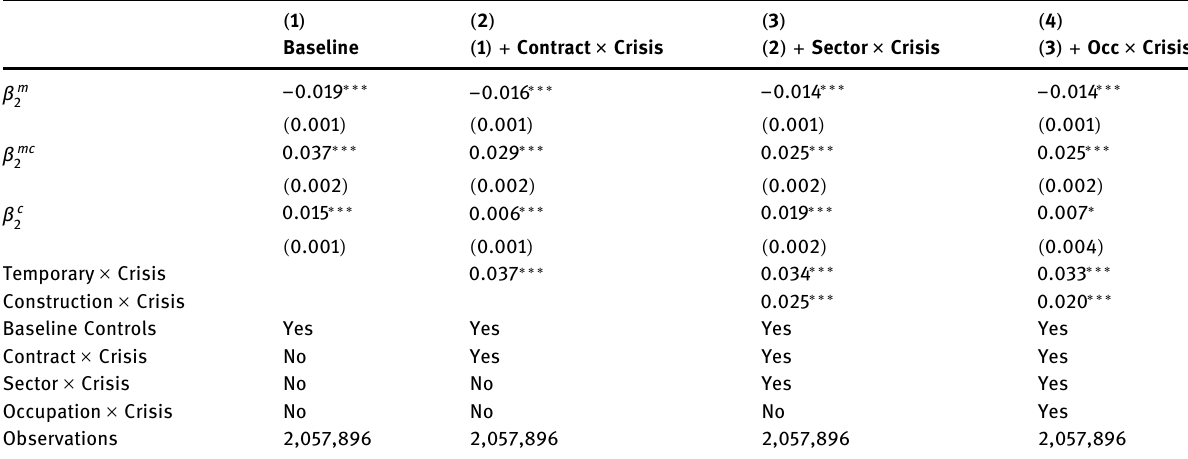
Table A2: Estimation results: EU. Robustness